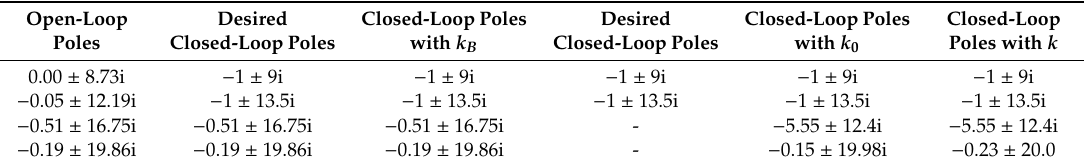
Table 4. Open-loop and closed-loop poles comparison: traditional technique and the proposed method (test-case